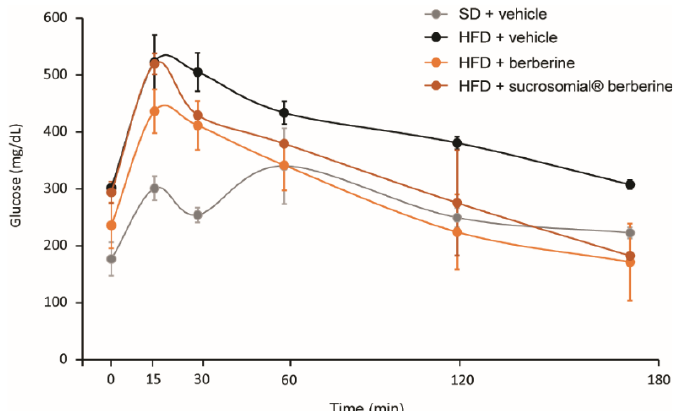
Figure 5. Effect of HFD and Sucrosomial ® berberine treatment on body weight of C57BL/6 mice during the 16 weeks of treatment. *** p < 0.001; **** p < 0.0001 vs. time 0. ° p < 0.05; °°°° p < 0.0001 vs. SD at 16 weeks.